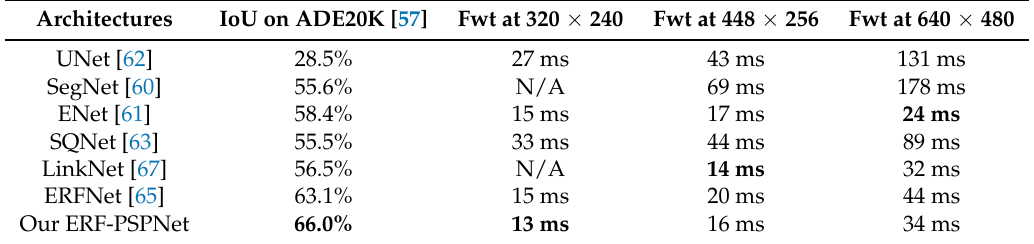
Table 2. Runtime and accuracy analysis of our architecture compared to other networks that are also designed for real-time applications in the state of the art. IoU: Intersection-over-Union, Fwt: Forward pass time. The runtime are tested on a cost-effective GPU GTX1050Ti.